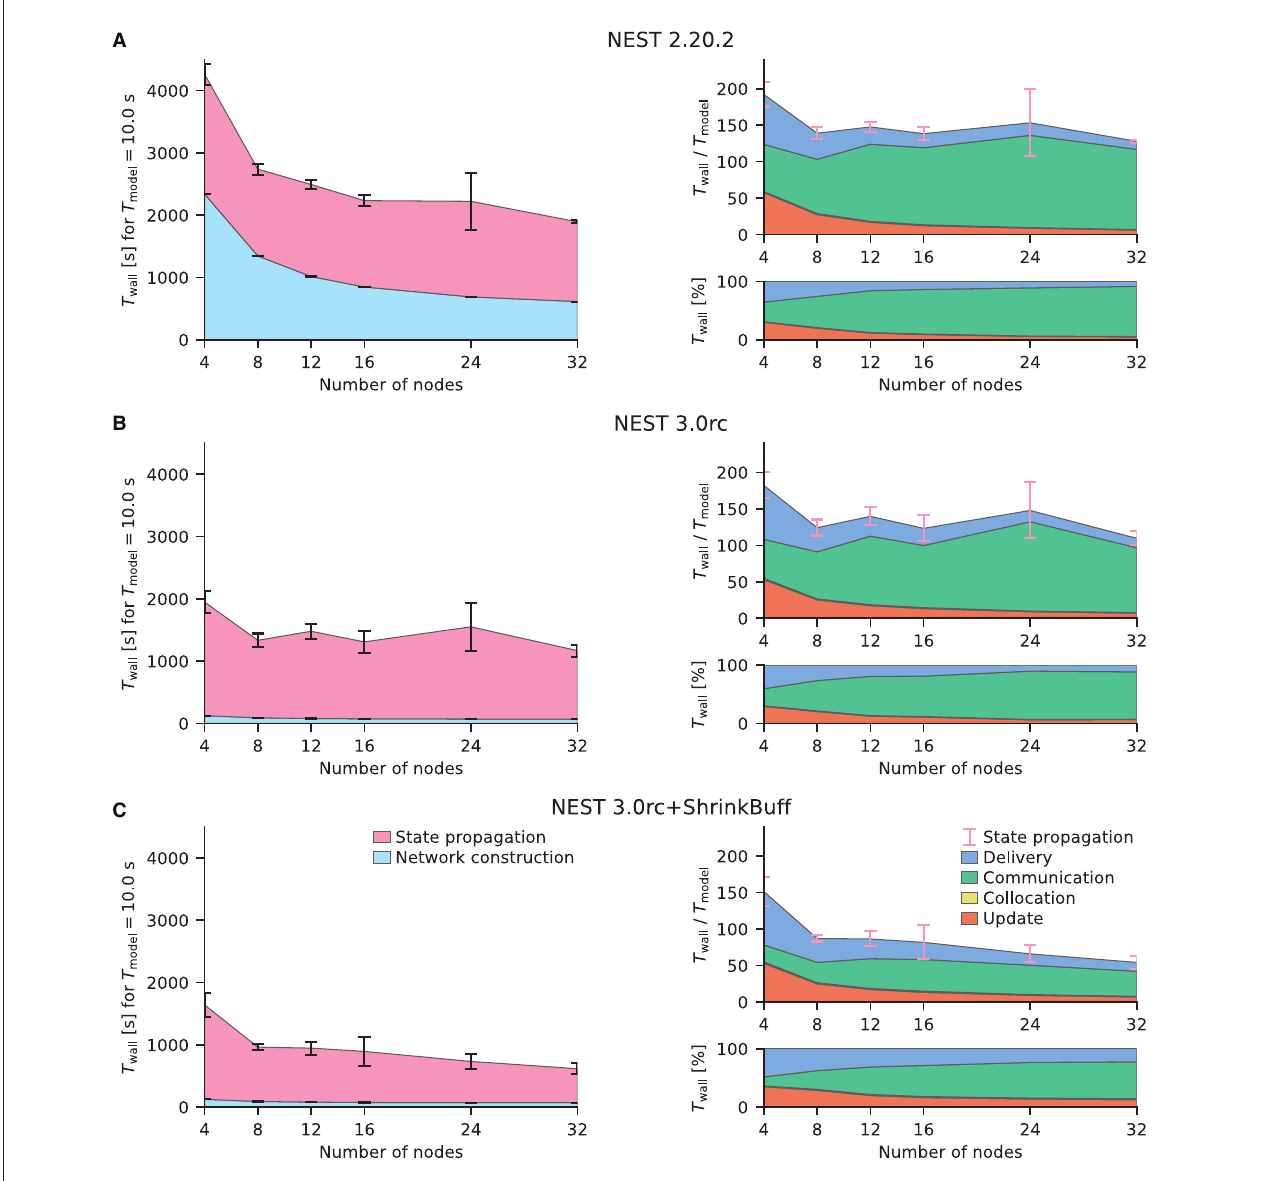
FIGURE 5 | Strong-scaling performance of the multi-area model on JURECA-DC. Same display as in Figure 4 . The multi-area model is simulated in its meta-stable state leading to a high amount of spikes that are communicated. The model time is T model = 10s. Simulations are repeated for 10 different random